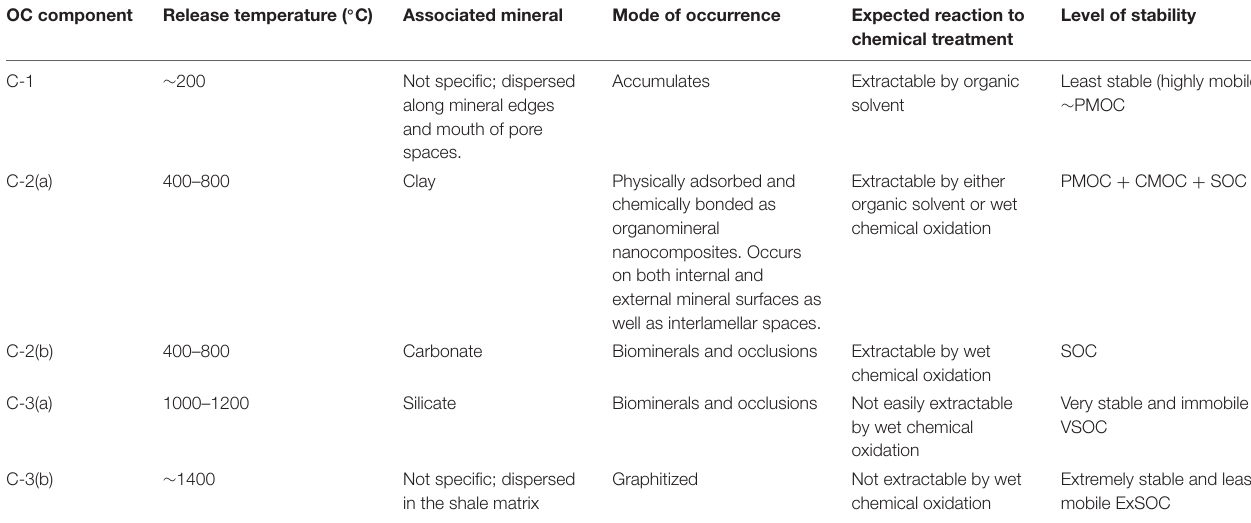
TABLE 4 | OC components present in a shale as identified based on their variable release temperature during step heating.